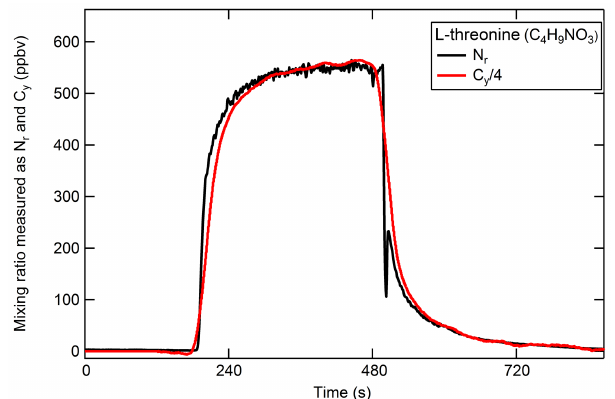
Figure 6. An example of the quantitative conversion of atomized polydisperse threonine (C 4 H 9 NO 3 ) to NO and CO 2 measured using NO − O 3 chemiluminescence and a LI-COR-6251, respectively. The measured total C y (red) is divided by the number of C atoms in threonine